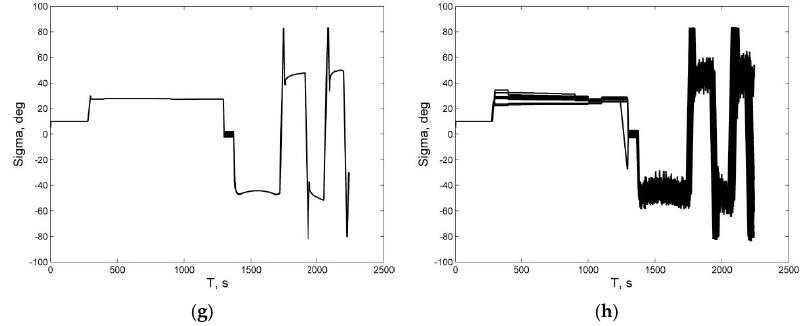
Figure 11. Simulations under Monte Carlo dispersions in a skip re-entry: ( a ) skip re-entry lateral nominal trajectory, ( b ) skip re-entry lateral histories, ( c ) nominal velocity versus altitude trajectory, ( d ) velocity versus altitude histories, ( e ) nominal downrange trajectory, ( f ) downrange histories, ( g ) nominal bank angle, ( h ) bank angle histories.